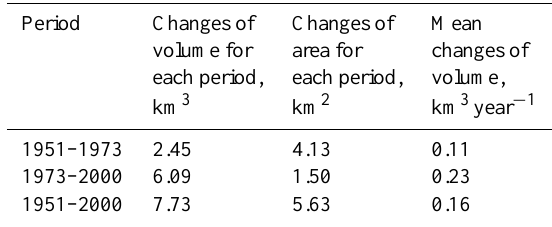
Table 2. The measured areas and volumes of Trofim-Kumaga sands on the Trofimovskaya branch close to Sardakh Island over various time